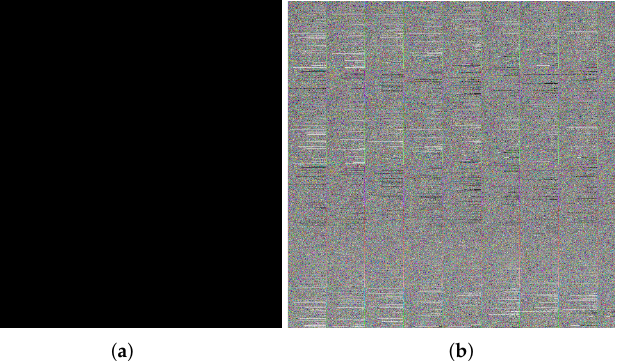
Figure 8. The result of the second version of the deterministic noise. ( a ) Black image. ( b ) Determinis- tic noise added to ( a ).